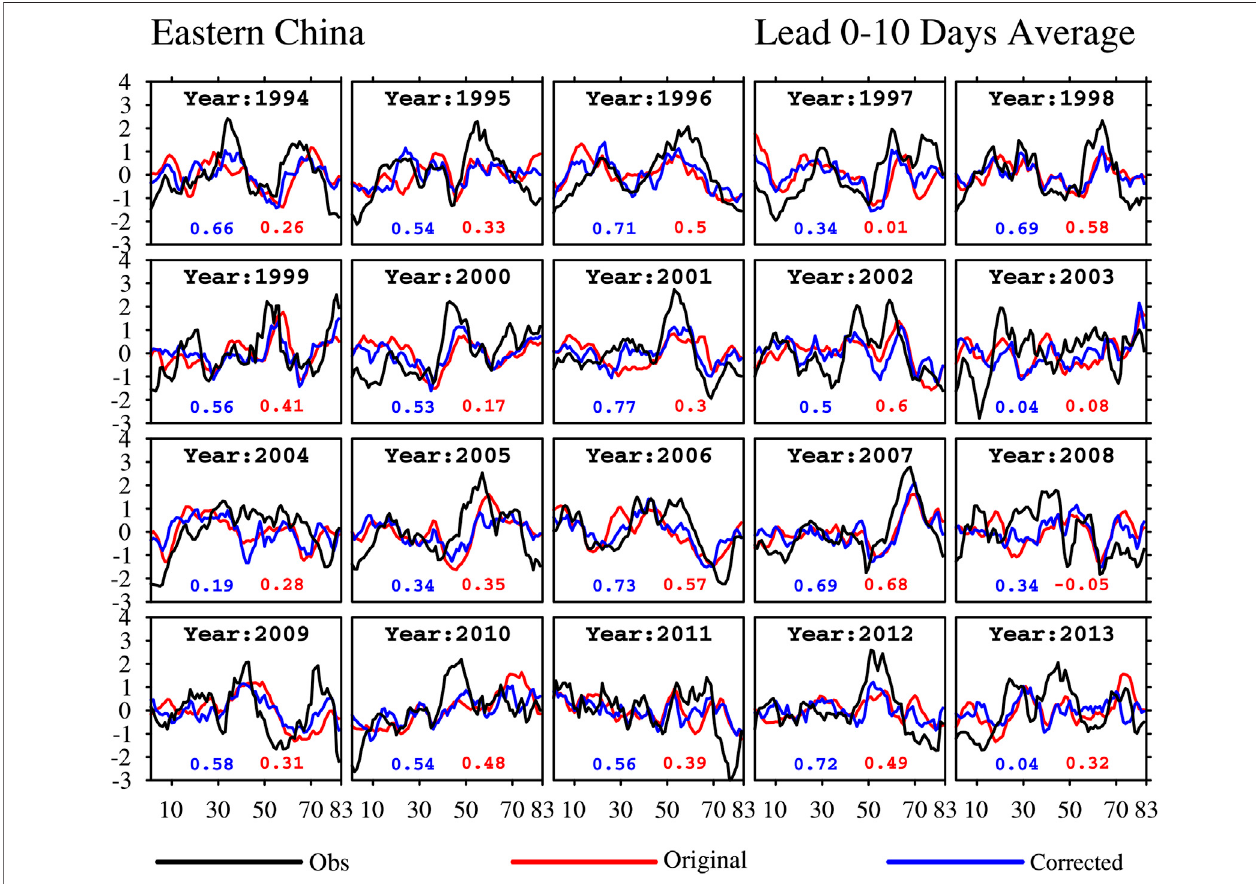
FIGURE 3 | Normalized time series of the observed (black line), originally predicted, and the bias corrected 10-day moving accumulated precipitation anomalies with the forecast lead time of 0 – 10 days regionally averaged over Eastern China in each year of 1994 – 2013. The blue and red marked values represent the TCC values between the predictions with or without the bias correction and observations,